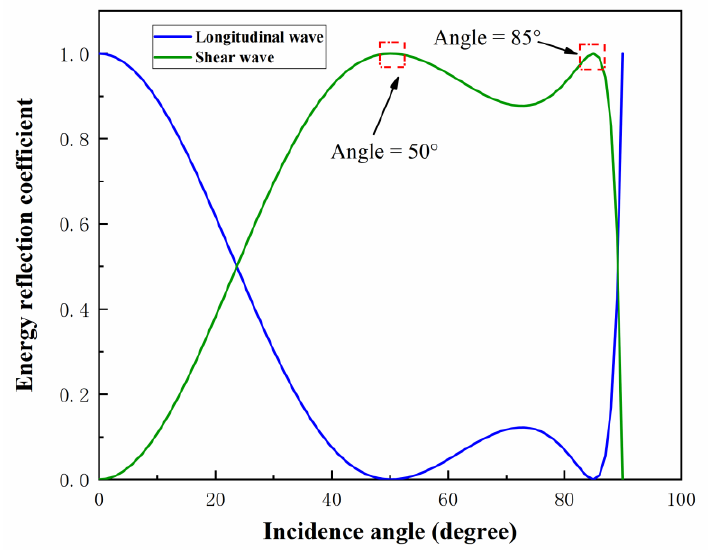
Figure 10. Reflection and mode conversion by an incident longitudinal wave as it impinges a Titanium-Air interface.